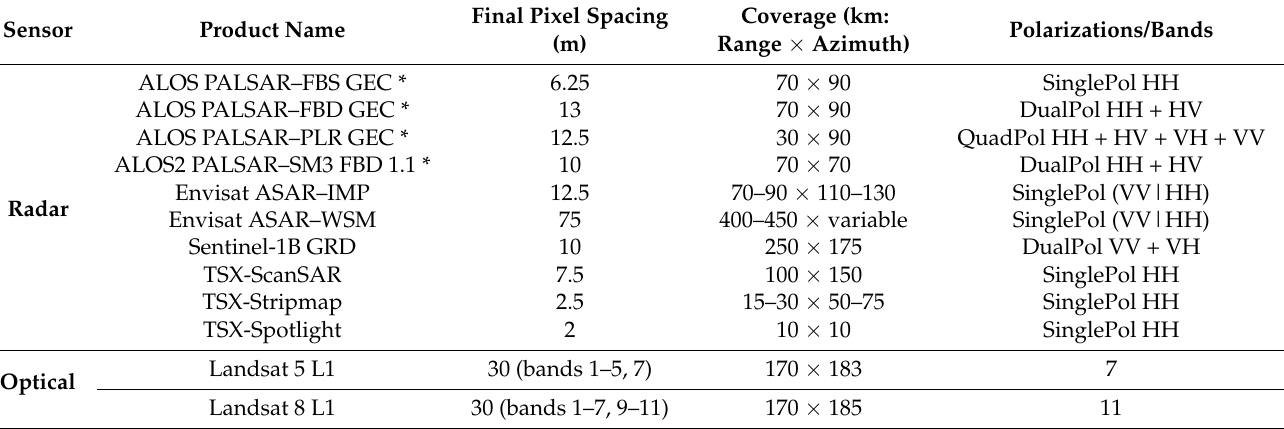
Table A1. Satellite data used for validation and its